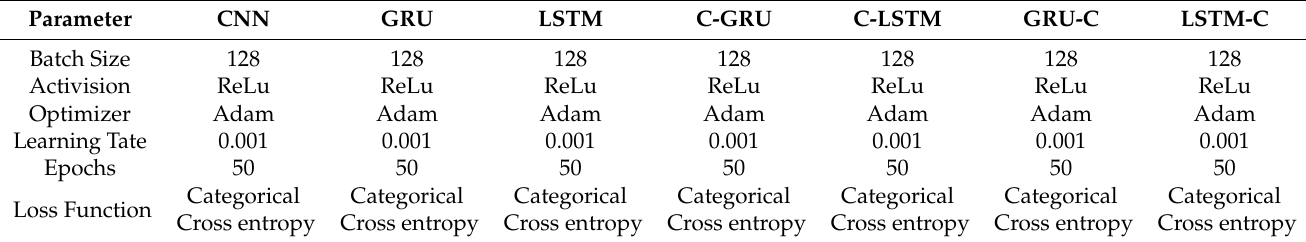
Figure 10. Smartphone placement classification result. 4.3. Results of Moving Speed Estimation Table 2 shows the results of augmenting data of 12 h to 96 h with time-warping, using them to train seven models, and evaluating the accuracy of each model in estimating the moving speed with a validation data set of 2 h. Of the seven supervised learning models, the best performing model was the LSTM-C model, with approximately 95.6% accurate